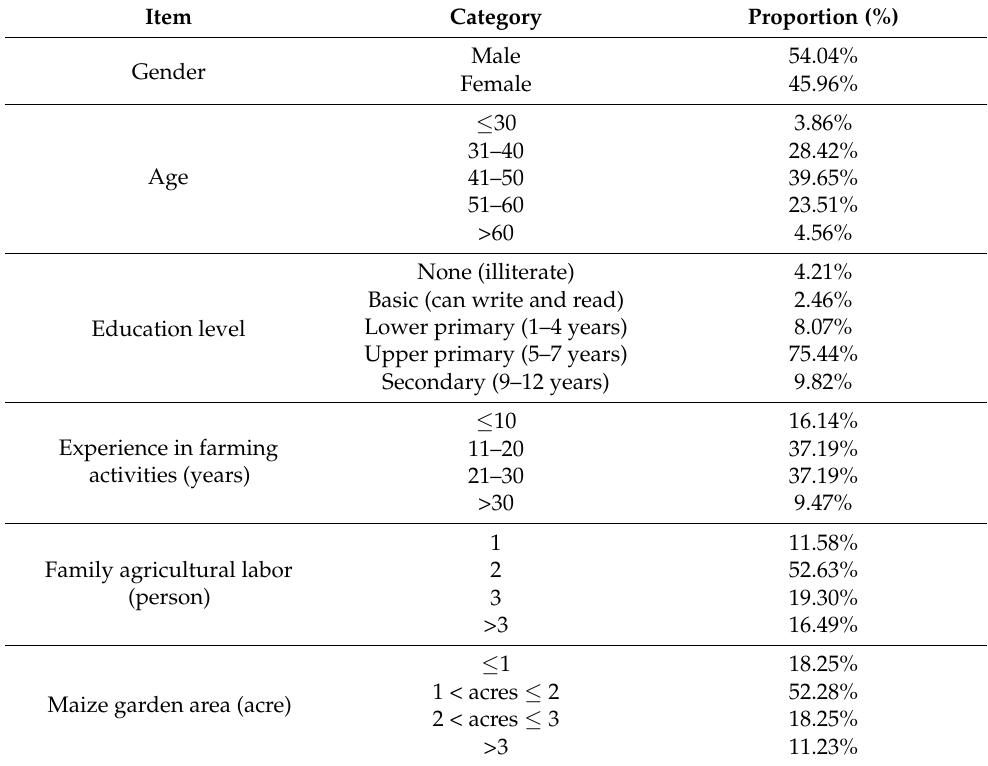
Table 2. Basic characteristics of